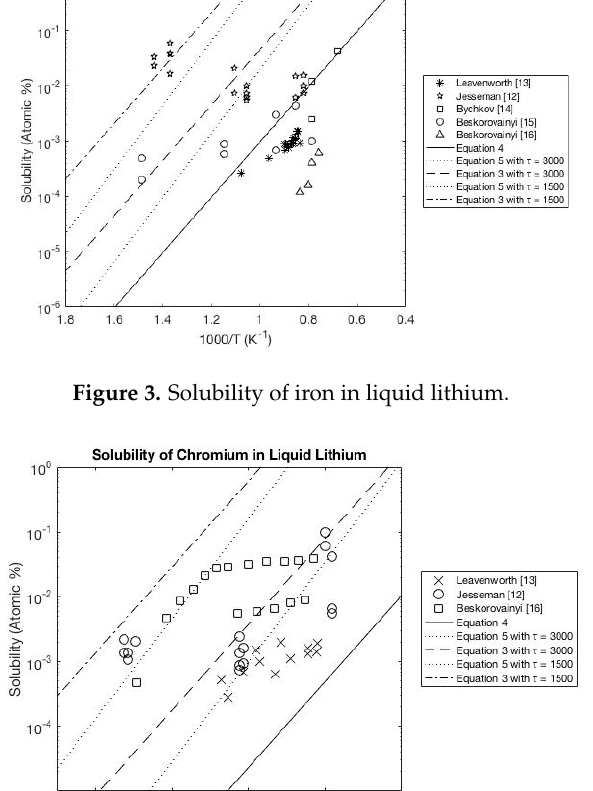
Figure 4. Solubility of chromium in liquid lithium.